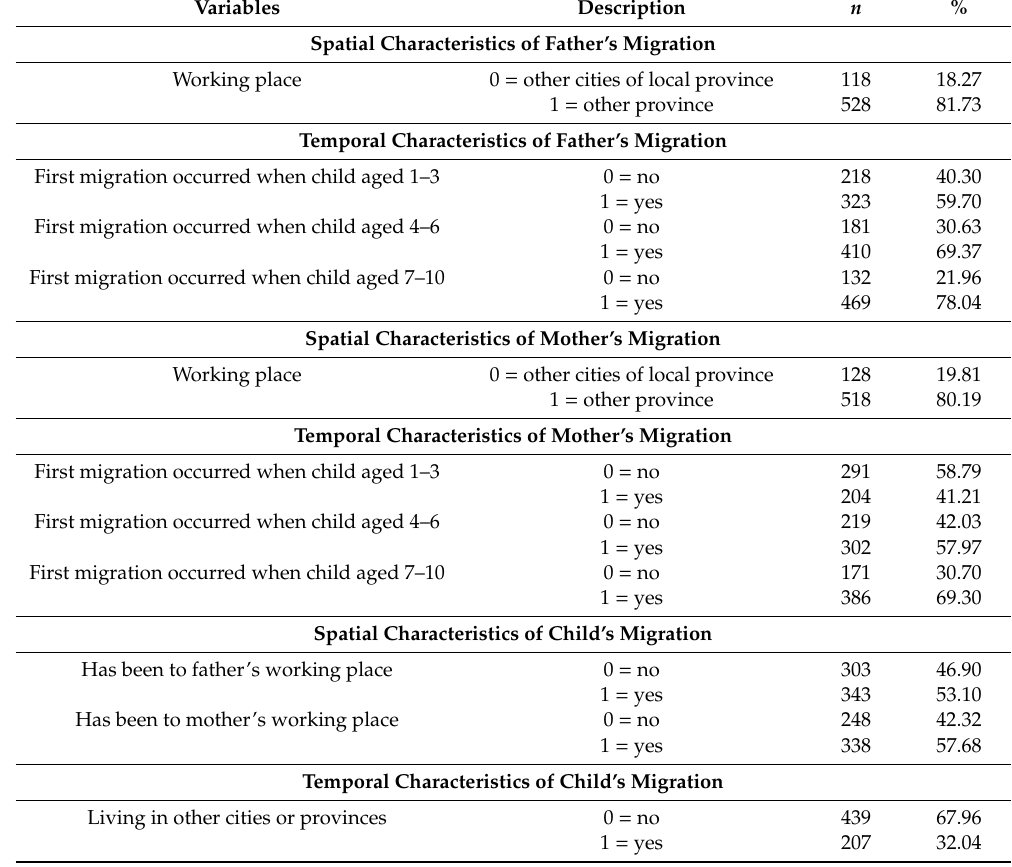
Table 2. Characteristics of population migration.